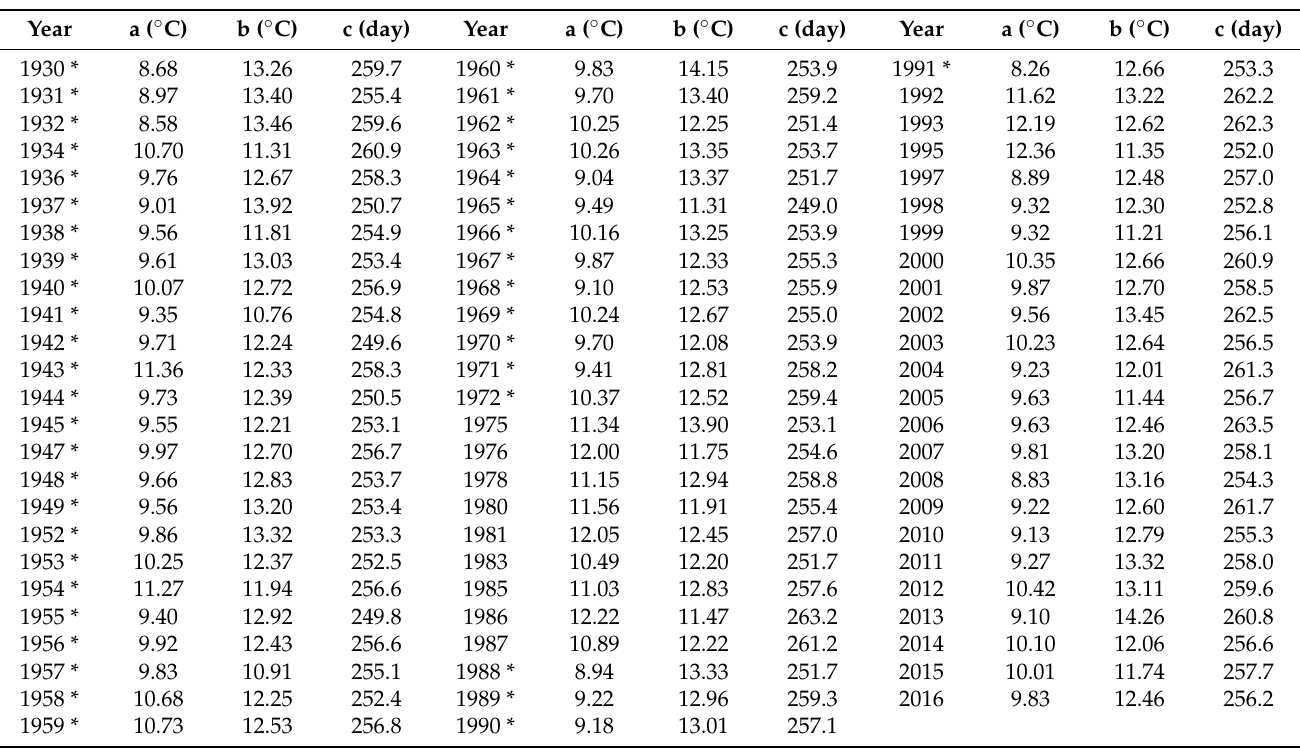
Table 1. Three parameters of the sinusoidal wave function for best fitting daily mean air temperatures in 74 years between 1930 and 2016.